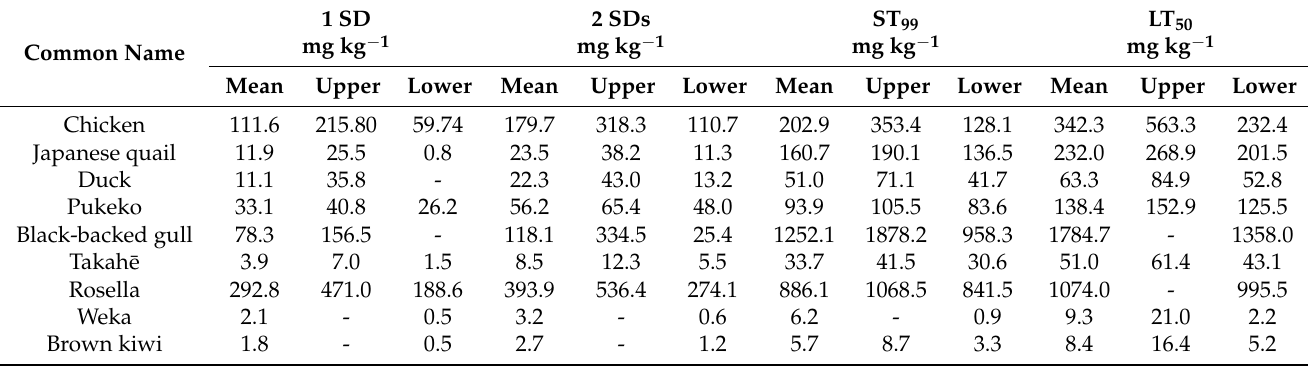
Table 2. Estimation of PAPP doses (mg kg − 1 ) in each bird species required to achieve the four threshold values (1 SD, 2 SDs, ST 99 and LT 50 ) with upper and lower confidence ( p <